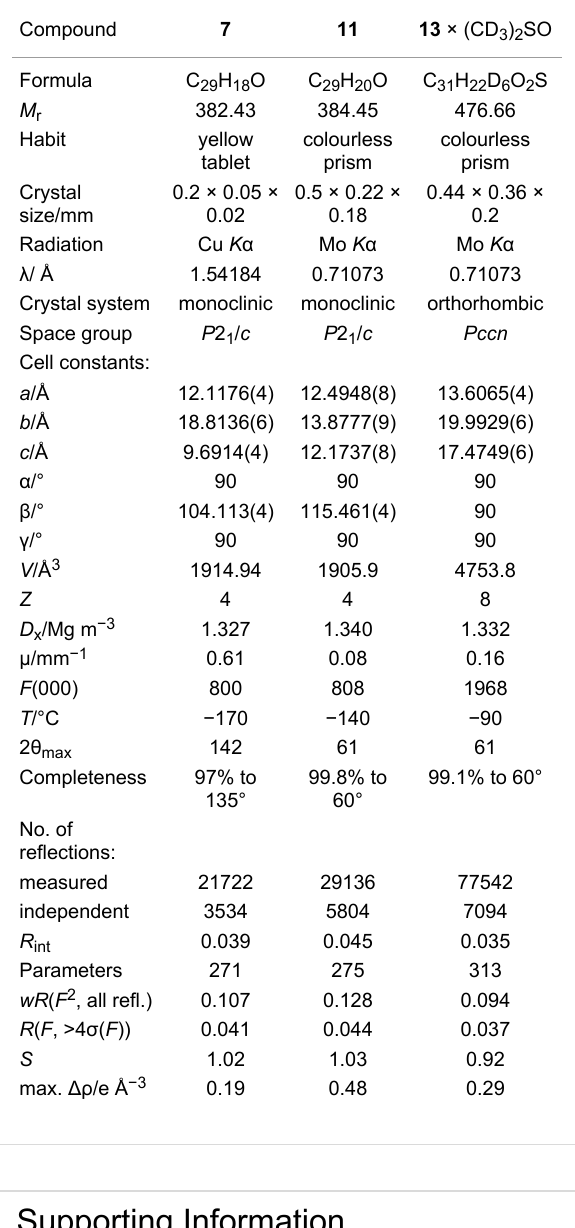
Table 2: Details of X-ray structure